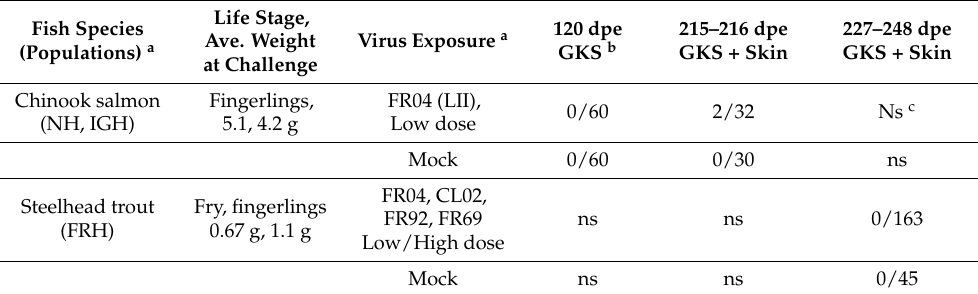
Table 4. Detection of IHNV by plaque assay in viral persistence studies in Chinook salmon or steelhead trout. Tissues were collected and processed individually from each fish, and numbers indicate the number of fish positive for virus/number